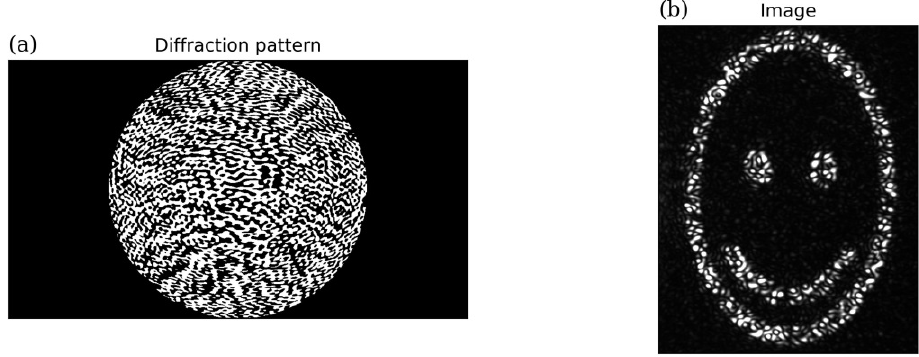
Figure 8. DLP as a holographic plate. ( a ) Diffraction pattern; ( b ) image in focal plane.